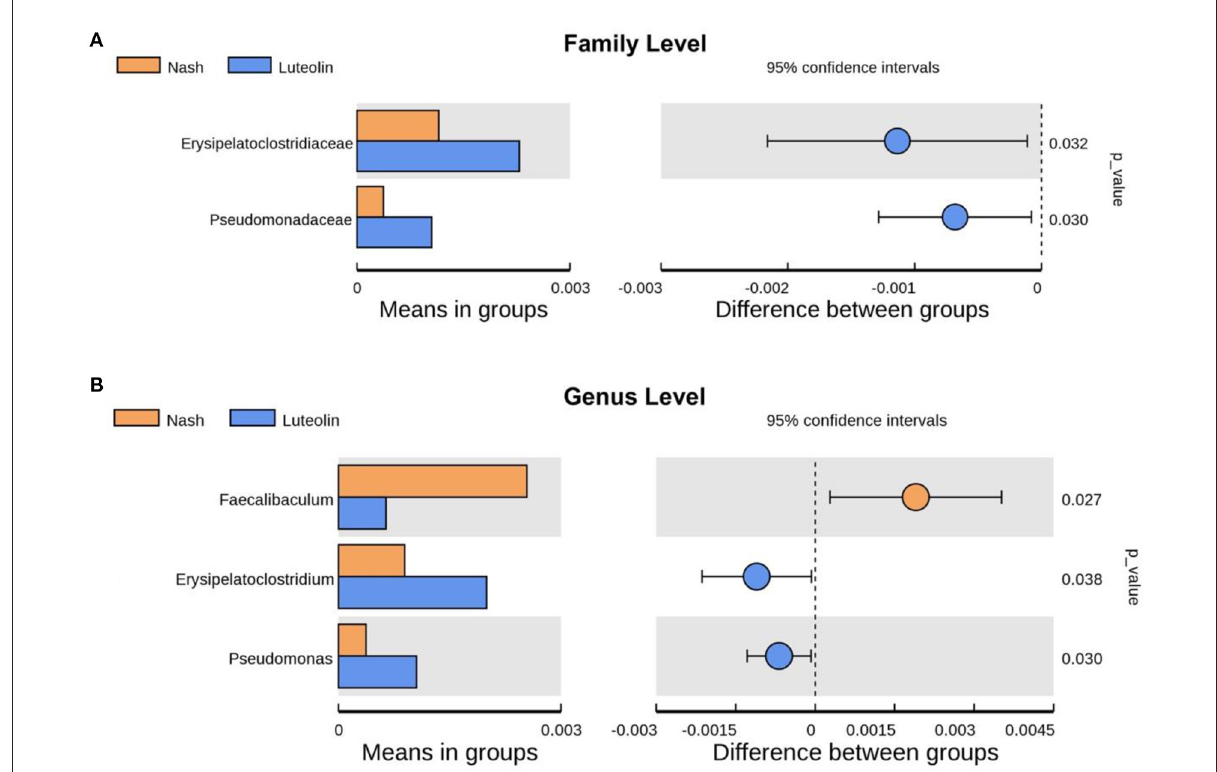
FIGURE6 Differential gut microbiome species between NASH and Luteolin groups at (A) family level and (B) genus level ( n = 6–8 per